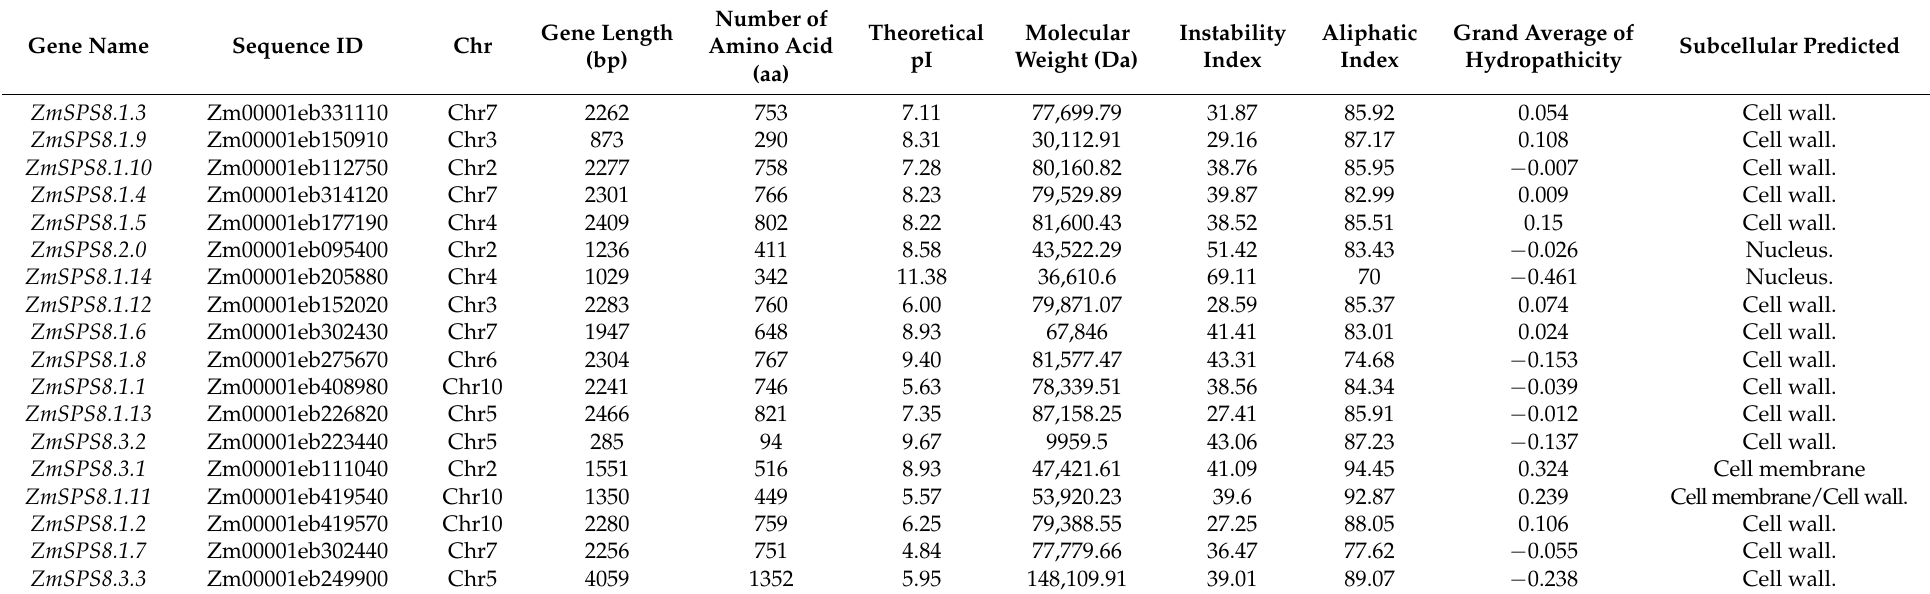
Table 1. Characterization of the serine peptidase S8 family genes and its